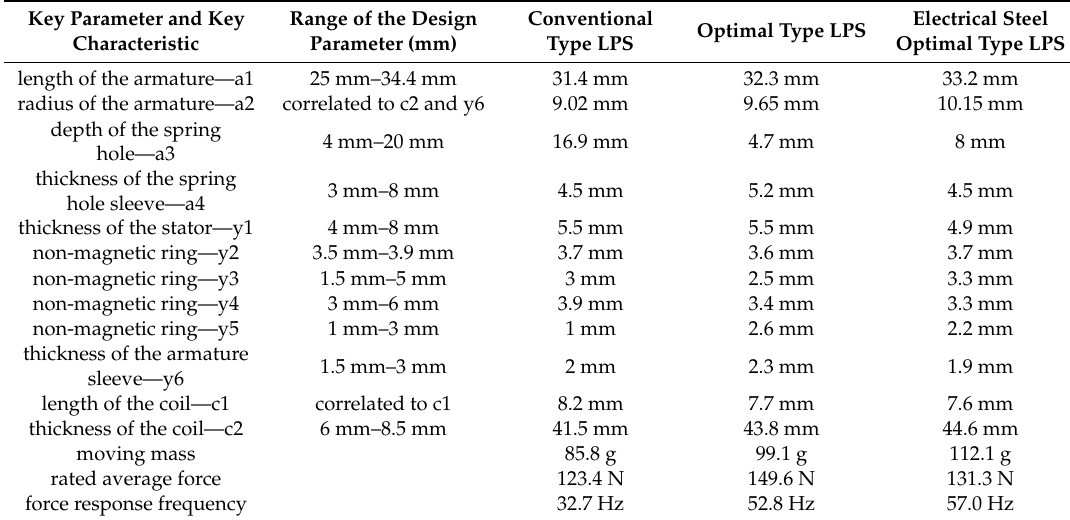
Figure 7. The multi-objective GA optimization iteration result of the LPS shape parameters. Table 1. The values and the design ranges of key design parameters and the key characteristics of the design